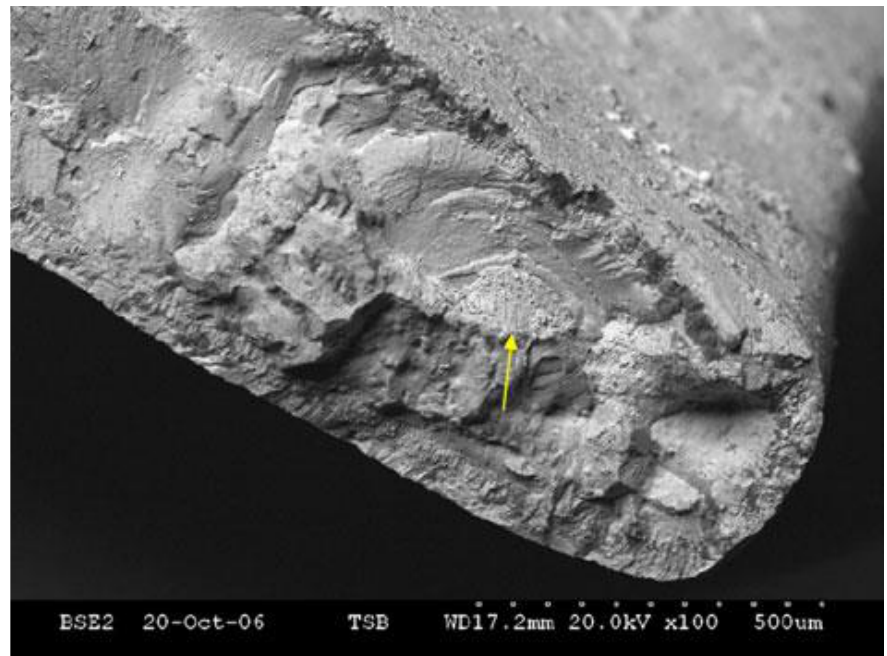
Figure 6. Failed turbine blade. Many grains had the appearance of conchoidal fracture surfaces; difficult to explain unless from the billowing shapes of bifilms. Very few areas of striations could be found on the fracture surface, suggesting a limited amount of fatigue in this so-called fatigue failure [39].